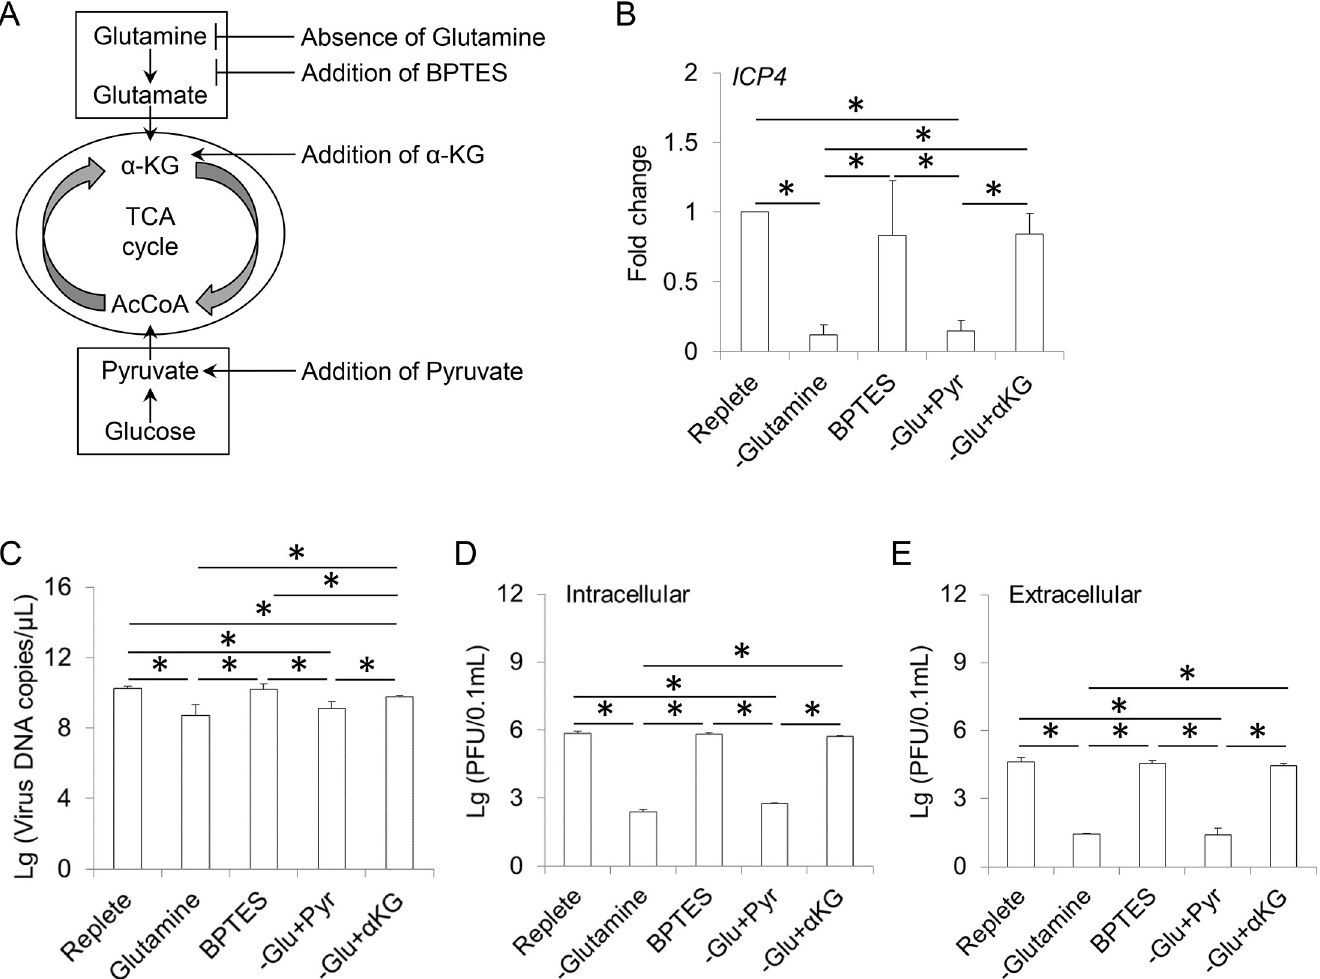
Fig 6. Effect of glutamine metabolism on ILTV infection. (A) Schematic presentation showing the experimental design. LMH cells were cultured in glutamine-free medium in the presence or absence of two TCA cycle intermediates, namely α -KG (5 mM) and pyruvate (Pyr, 8 mM), or overlaid with replete medium in the presence of glutaminolysis inhibitor BPTES (3 μ M). (B) The effect of glutamine metabolism on the transcription of ICP4 was detected by absolute RT-qPCR at 12 hpi (MOI 1). (C-E) The effects of glutamine metabolism on viral genome replication and virion production were determined by ILTV-specific qPCR (C) and plaque assays (D and E), respectively, at 48 hpi (MOI 1). The results of statistical analyses are presented as the mean ± SD, n = 3. Asterisks indicate statistical difference ( p <